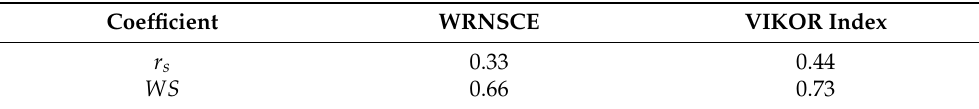
Table 5. Comparison of the rankings obtained by WRNSCE and the VIKOR index with reference ranking using r w and WS